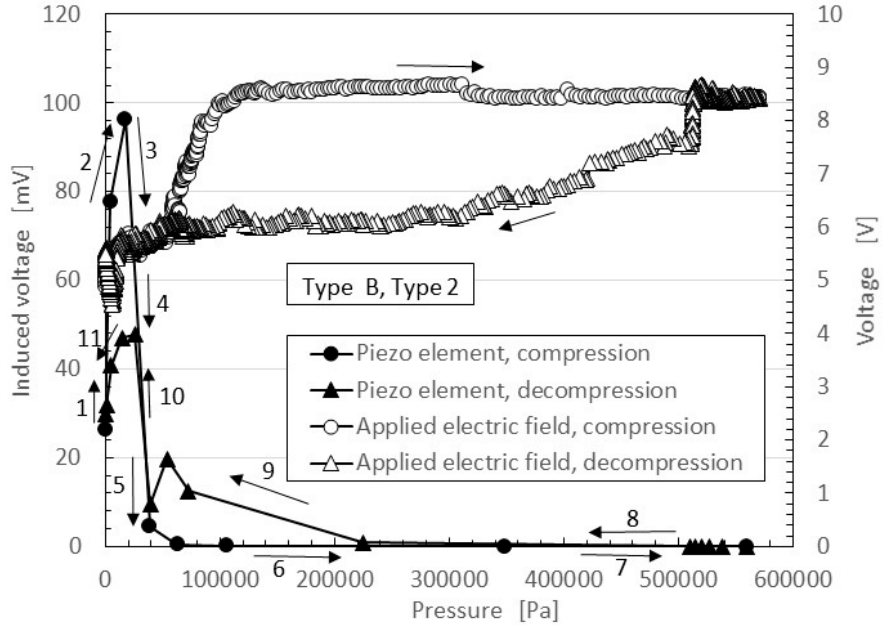
Figure 6. Typical results of the induced voltage and voltage flowing inside the MCF rubber by the application of a voltage.